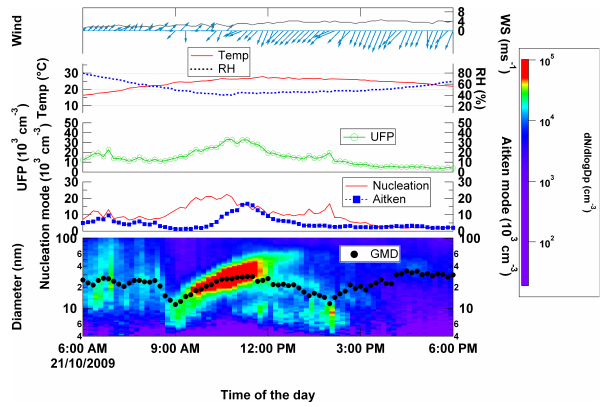
Fig. 8. The time series of nucleation events observed at QUT on 21 October 2009. From bottom to top, the parameters are: (i) Ge- ometric median diameter (GMD) and contour plot of size distribu- tion; (ii) Particle number concentration of nucleation and Aitken mode particles; (iii) Particle number concentration of ultrafine par- ticles (UFP); (iv) Temperature and relative humidity; and (v) wind direction and speed.